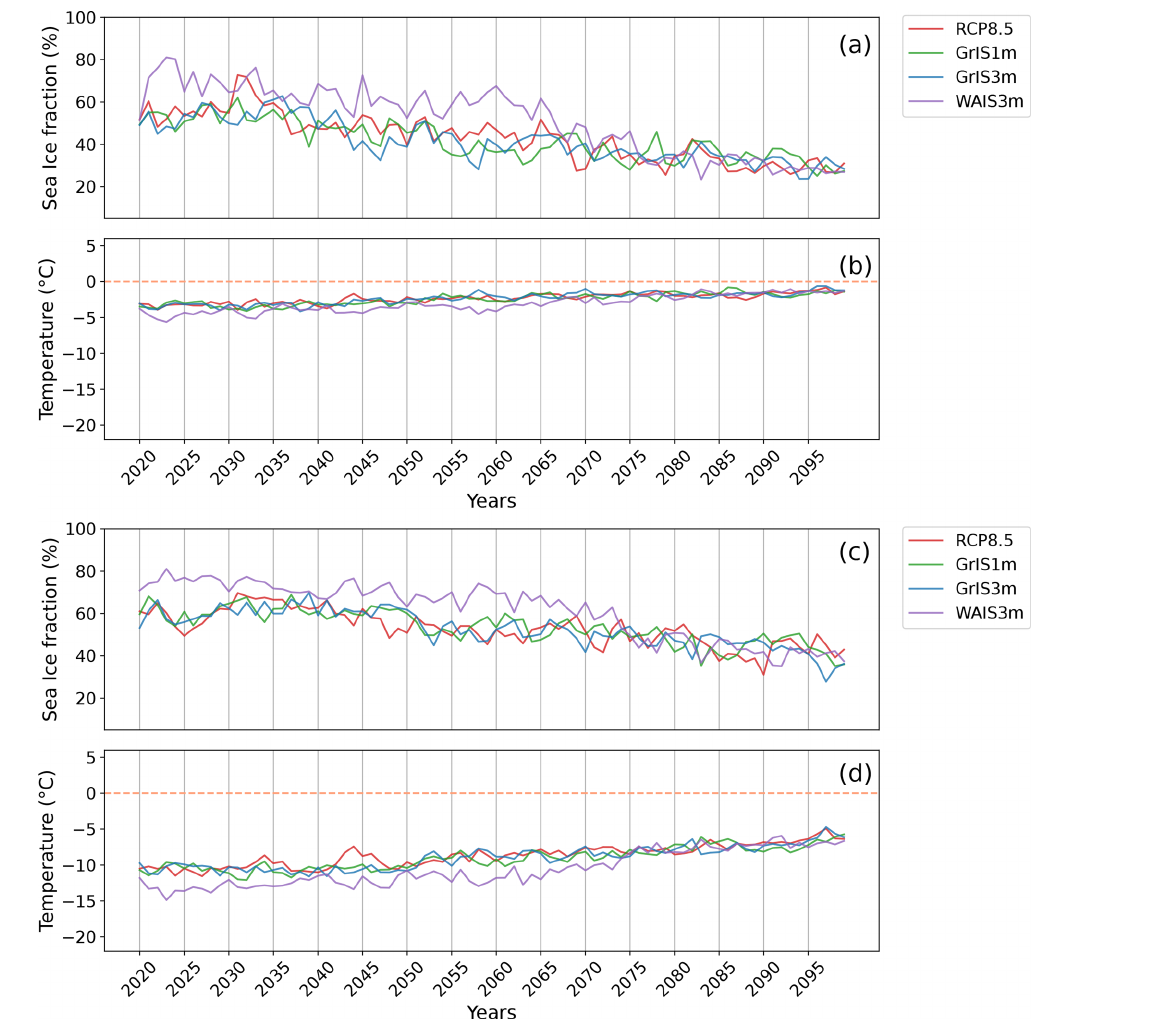
Figure B6. Temporal evolution of (a–c) sea ice fraction (%) and (b–d) temperature ( ◦ C) in the Southern Hemisphere for (a–b) NDJFM and (c–d) MJJAS. The orange dotted line represents the 0 ◦ C